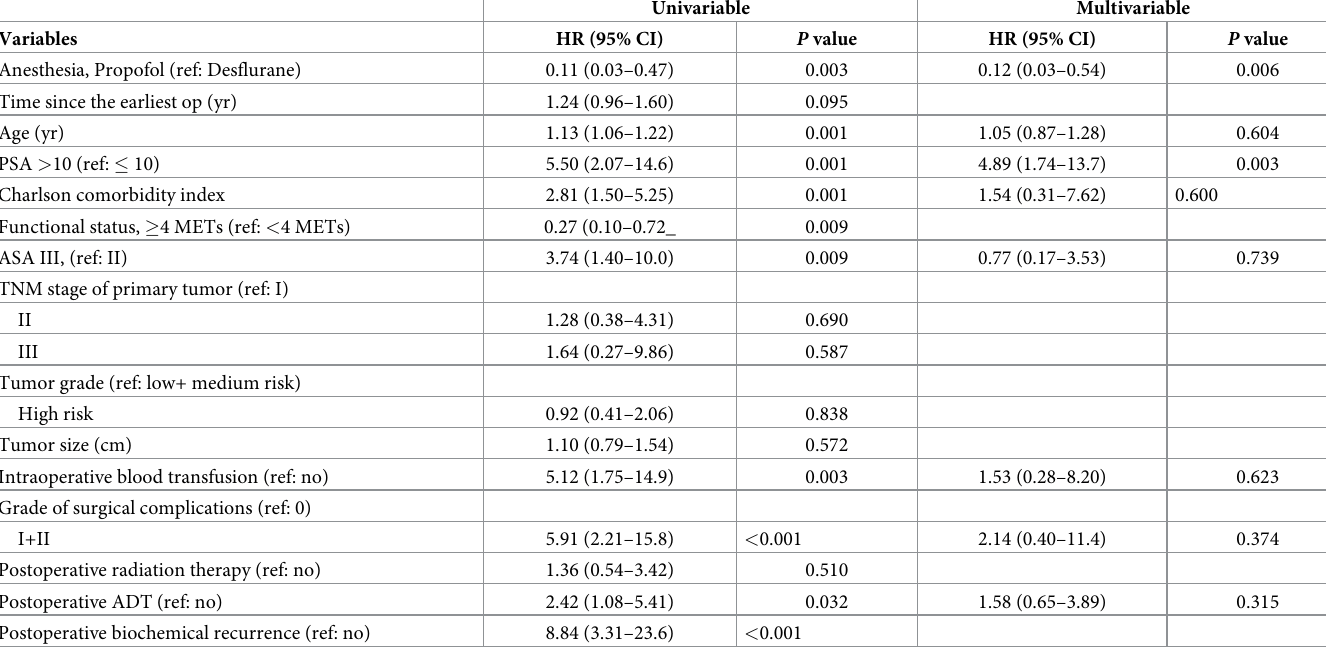
Table 2. Cox proportional hazards regression for mortality: Univariable and multivariable models for overall patients.